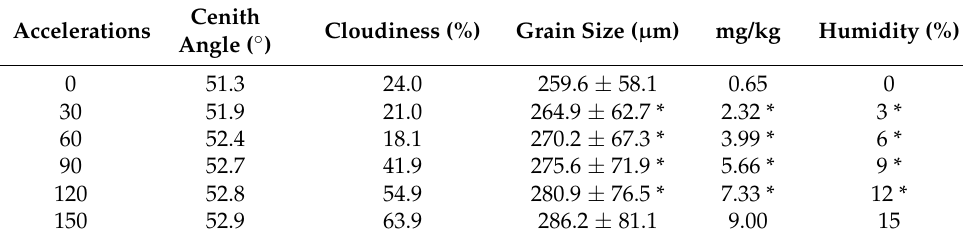
Figure 4. Example of an analyzed image on the calibrated card, including squares to illustrate the sizing of snow grains ( left ), and snow grain size distributions during each acceleration stage ( right ). Table 1. Parameters for snow contamination